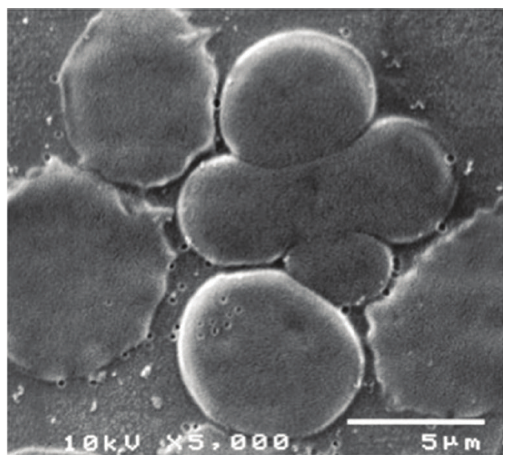
Figure 7: The magnification of one qRBC in blood film at SEM ( × 5000, 10kV).